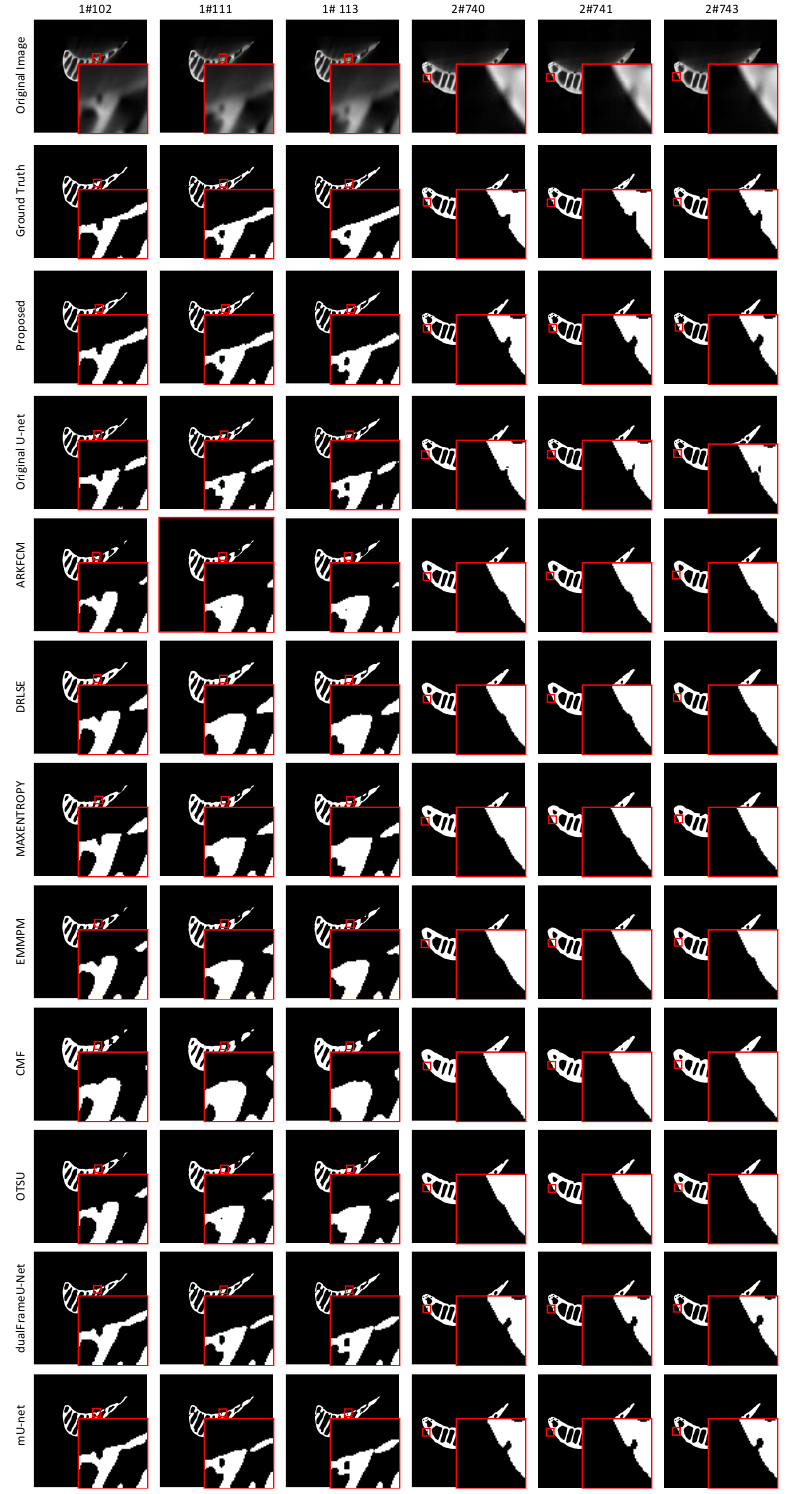
Figure 6. Experimental results of the proposed method, ARKFCM, DRLSE, MAXENTROPY, EM/MPM, CMF, OTSU, conventional U-net, dual-frame U-net and mU-net.